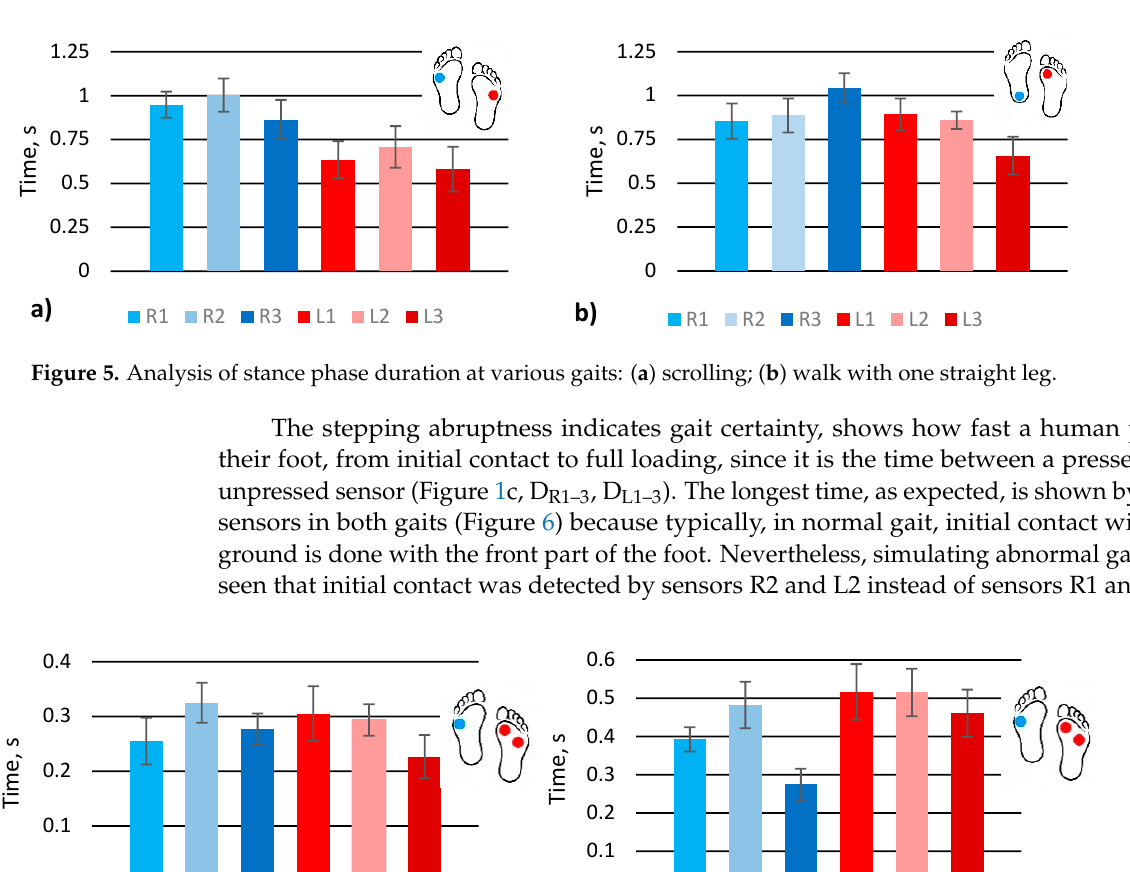
Figure 4. Analysis of signal amplitudes obtained from simulating various gates: ( a ) turnaround; ( b ) scrolling; ( c ) upstairs; ( d ) downstairs; ( e ) upstairs one by one; ( f ) walk with left straight leg.